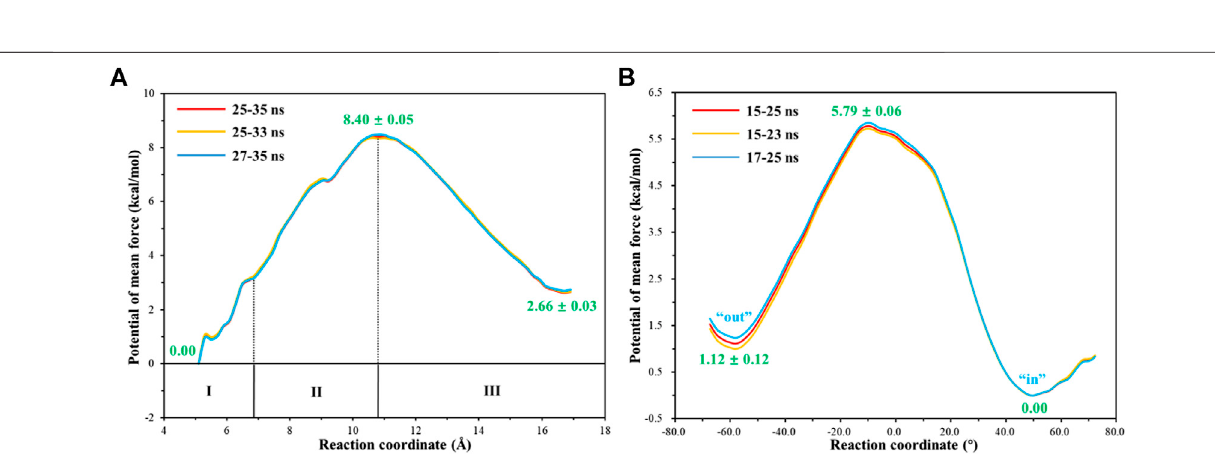
Frontiers in Chemistry |